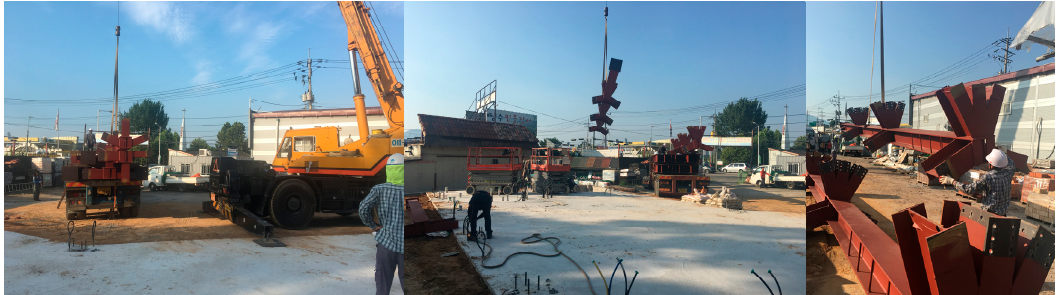
Figure 8. Transportation of the steel frame members to the laydown area.